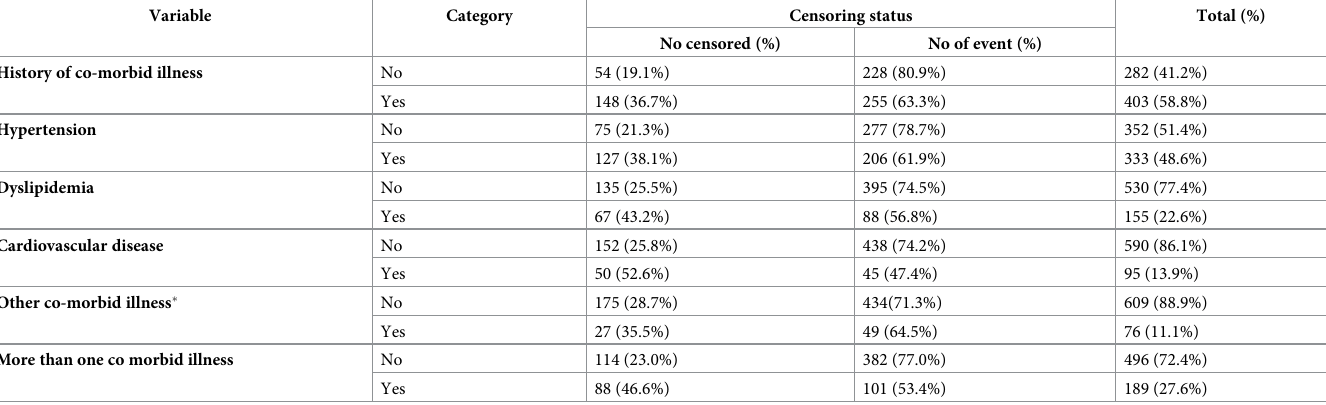
Table 3. Co-morbid illness and censoring status among T2DM patients, Addis Ababa, 2018 (n =